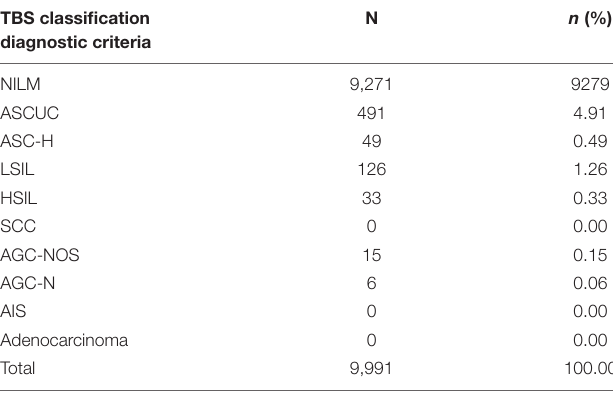
TABLE 6 | Thinprep cytology test (TCT) cervical cancer screening results.